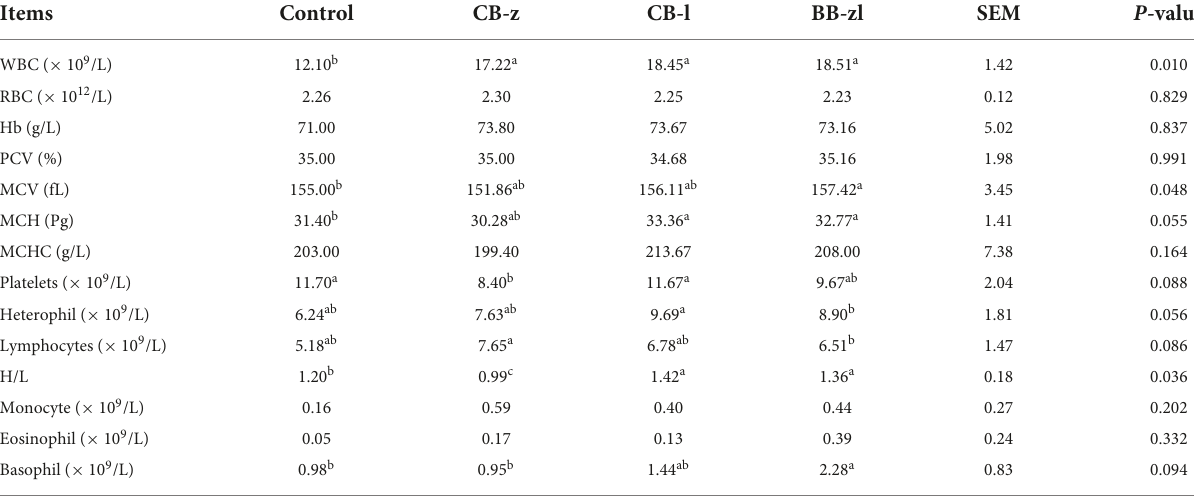
TABLE 4 Effects of Clostridium butyricum and Brevibacillus sp. on the hematological indices of laying hens. Items